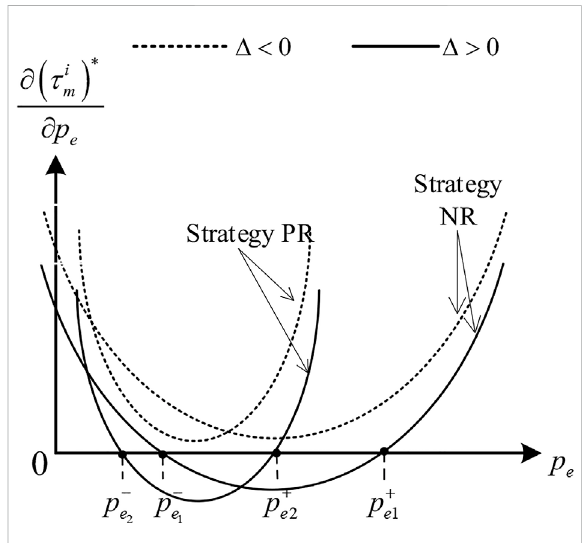
FIGURE 6 The fi rst partial derivative of the emissions reduction level with respect to p e . under strategies PR and NR. FIGURE 7